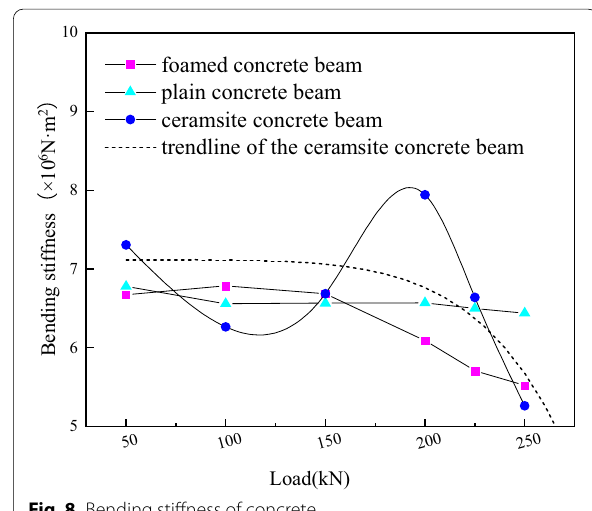
Table 3 Limit bending stiffness.